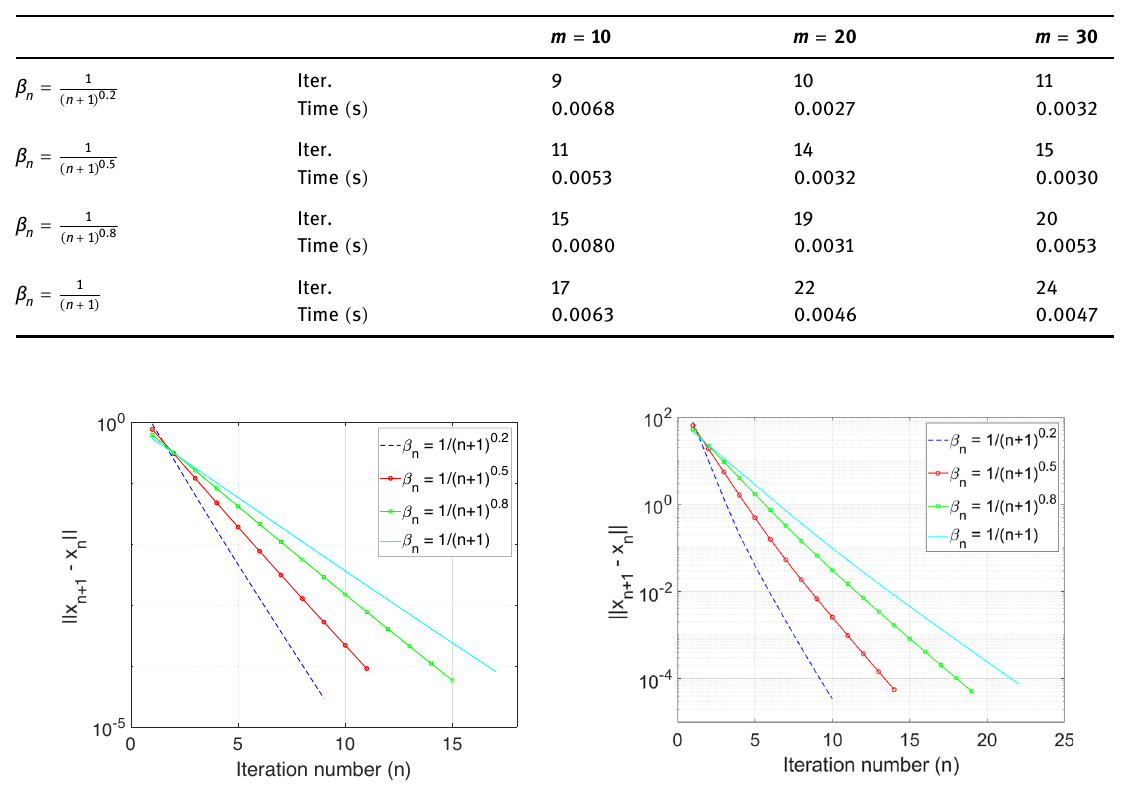
Table 1: Computation result for Example 4.1